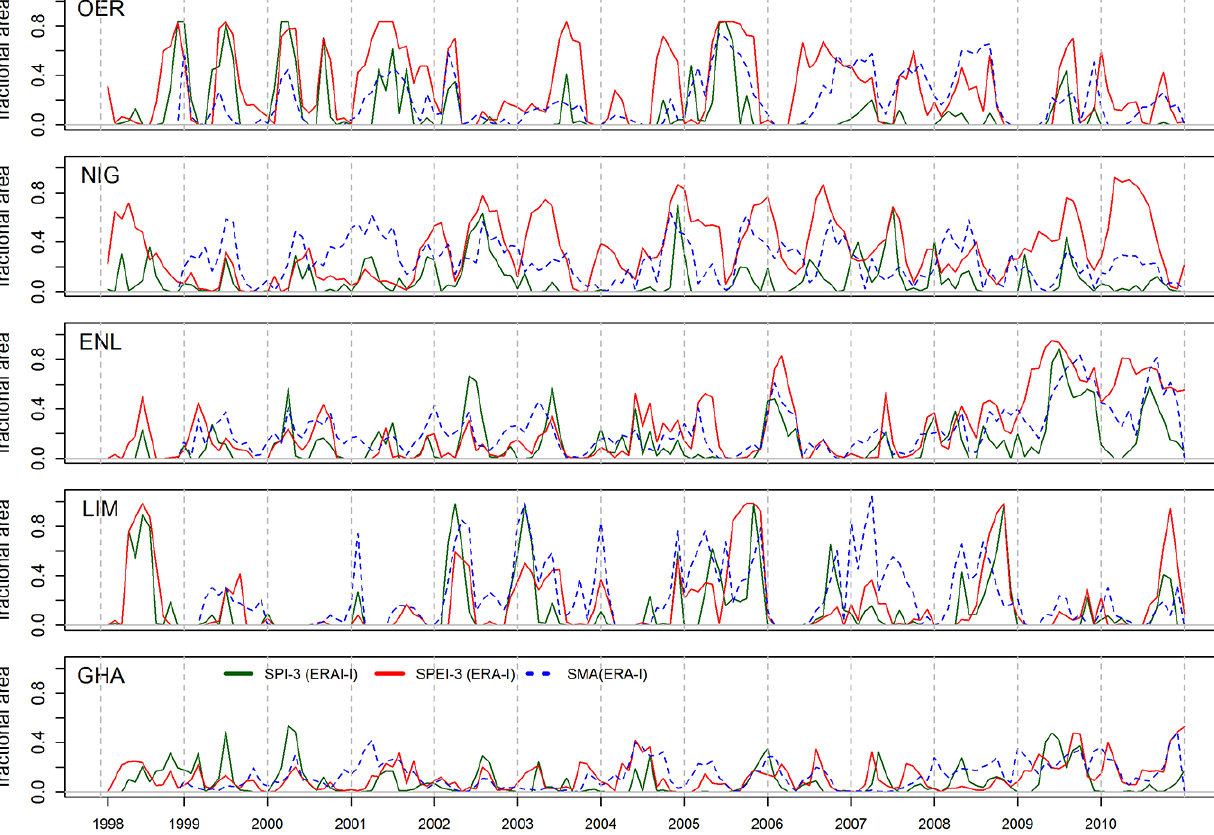
Fig. 8. Fractional area of each region under SPI, SPEI and SMA below − 1.0 for the period 1998–2010. OER: Oum er-Rbia, NIG: Inner Niger Delta, NIL: Eastern Nile, LIM: Limpopo Basin and GHA: Greater Horn of